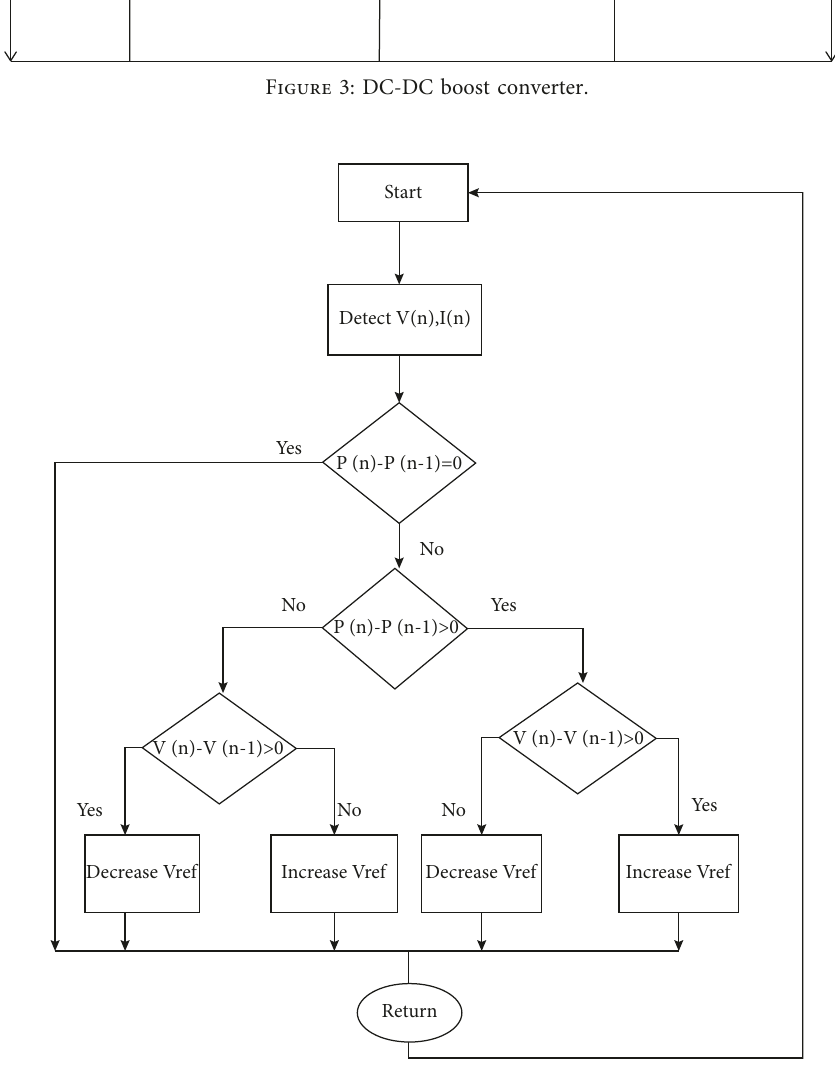
Figure 4: Perturb and observe algorithm.